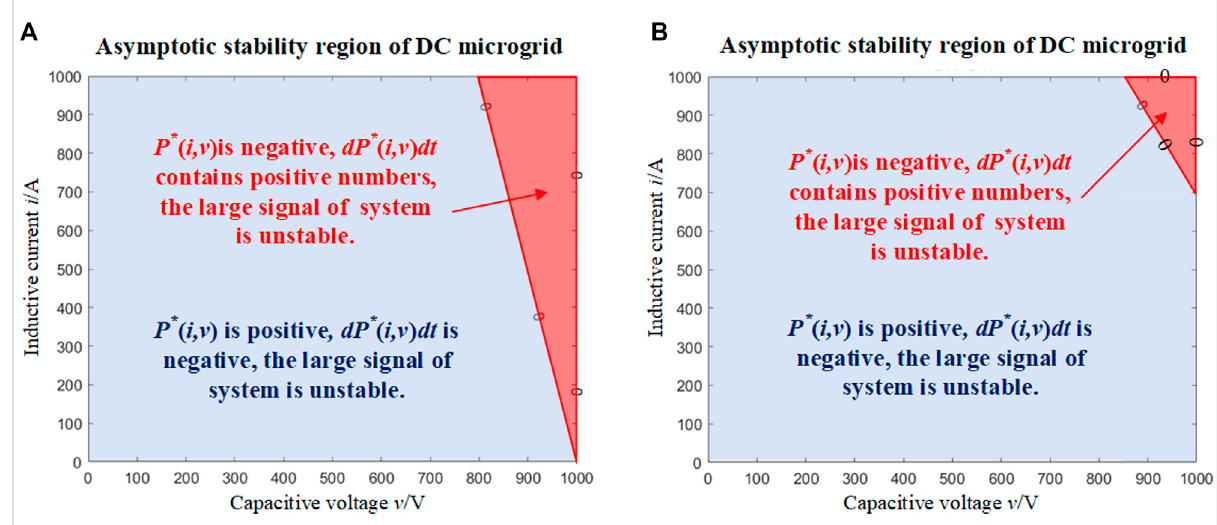
FIGURE 7 Asymptotic stability region under PI control and VDM control. (A) Asymptotic stability region under PI control. (B) Asymptotic stability region under VDM control.